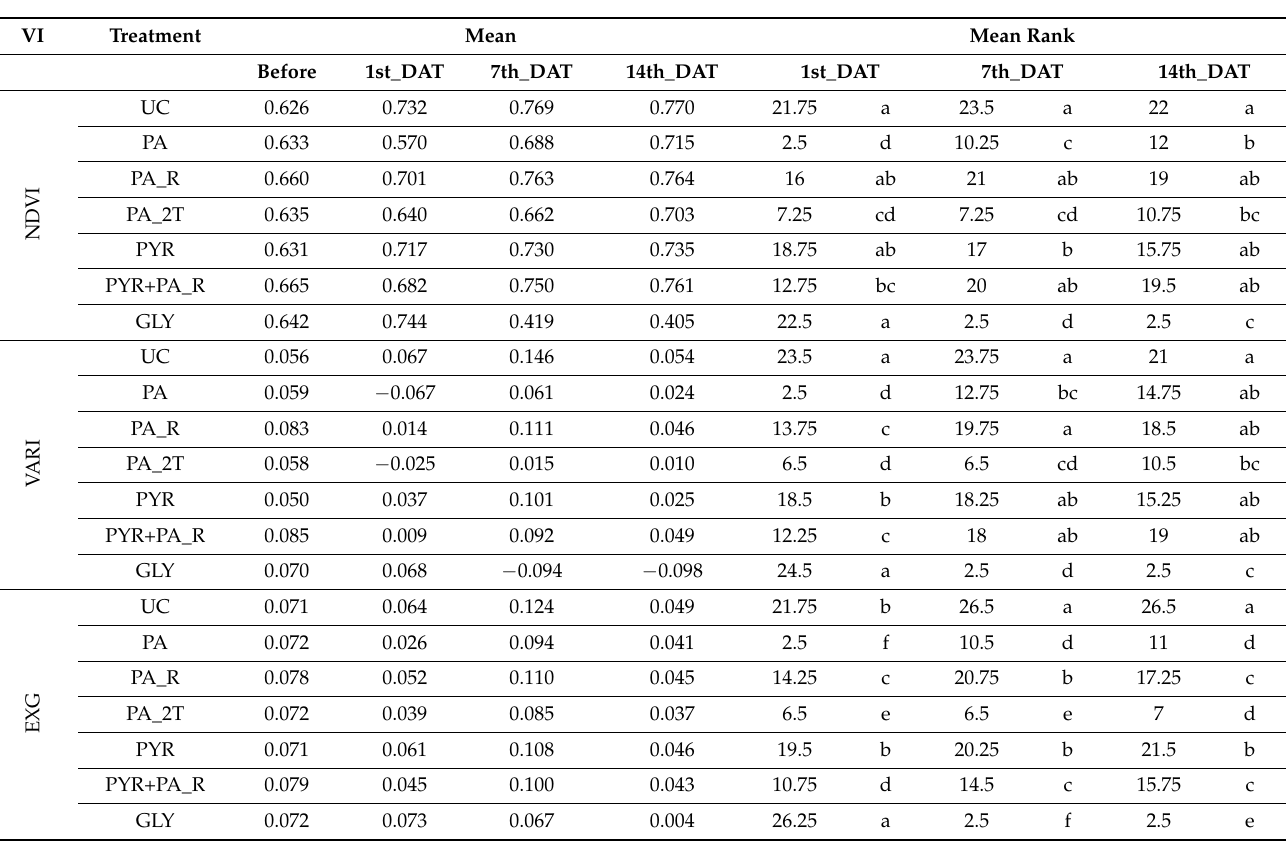
Table A2. Results of a comparison of treatments using absolute values of vegetation indices at different DATs in